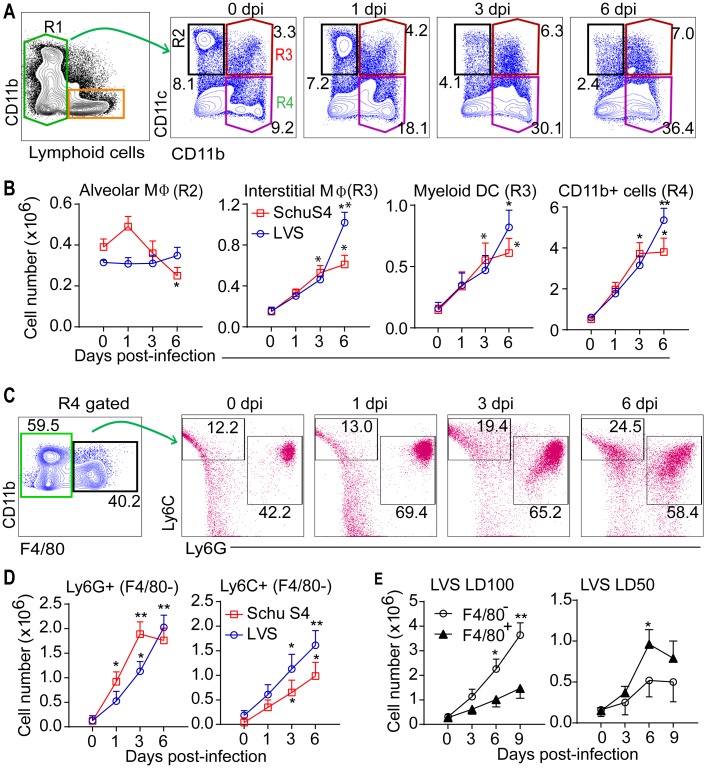
Ft elicts recruitment of IMC with MDSC phenotype.(A) Flow plots of multiple myeloid cell analysis scheme in in Ft LVS-infected lungs. Ft-infected lung cells were stained for cell-specific markers (see Methods); lymphoid cells were excluded and cells in R1 gate were analyzed for CD11b and CD11c expression. (B) Cell numbers of myeloid subsets from LVS or SchuS4 infected mice were compared with control mice (0 dpi) using gating strategy as shown in S4A–S4G Fig(mean ± SD of two (SchuS4, n = 6 mice) or three (LVS, n = 9 mice) independent experiments, Student’s t-test, *p<0.05 and **p<0.01 indicate differences at various dpi). (C) Cells from R4 gate were analyzed for F4/80, Ly6G and Ly6C expression. (D) Cell numbers of Ly6G+ and Ly6C+ cells from F4/80- population in LVS or SchuS4 infected mice (mean ± SD of two (SchuS4, n = 6 mice) or three (LVS, n = 9 mice) independent experiments, Student’s t-test, *p<0.05 and **p<0.01 indicate differences at various dpi). (E) Cell numbers of F4/80+ and F4/80- cells (R4 gated) in lungs following lethal (1000 cfu) or sub-lethal (500 cfu) LVS infection (mean ± SD of two experiments, Student’s t-test, *p<0.05 indicates a difference between LD100 and LD50).